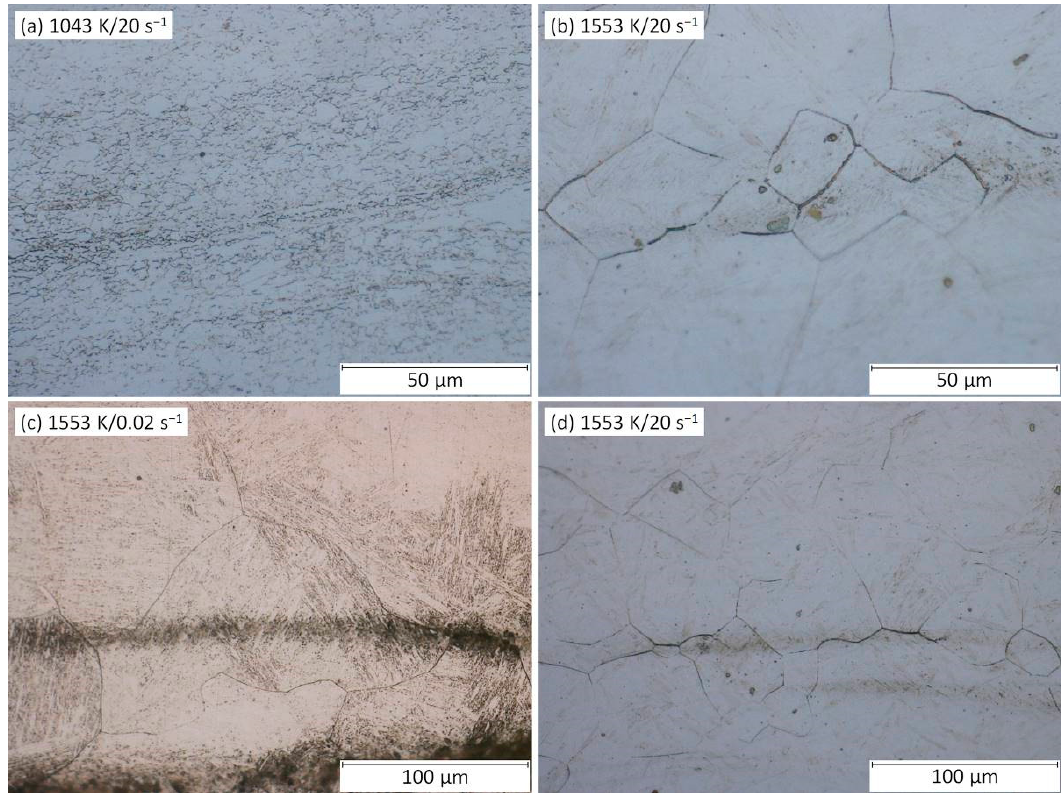
Figure 6. OM images of samples deformed under the true strain of 1.0. ( a ) 1043 K/20 s − 1 , ( b ) 1553 K/20 s − 1 , ( c ) 1553 K/0.02 s − 1 , ( d ) 1553 K/20 s − 1